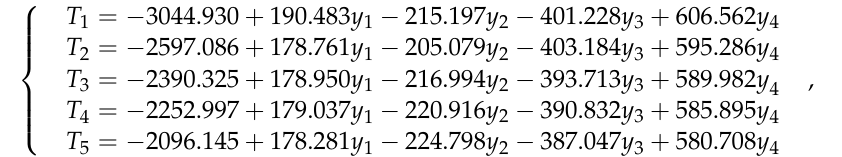
Figure 10. Number of pixel points in each cluster.